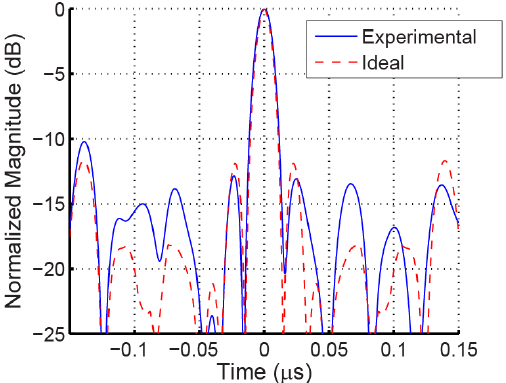
Figure 11. Comparison of ideal and RF probed measured time domain matched filter response, in dB, for a 5-chip 915 MHz OFC SAW device. The SAW device’s non-ideal time response, when correlated with the ideal matched filter, provides good correlation